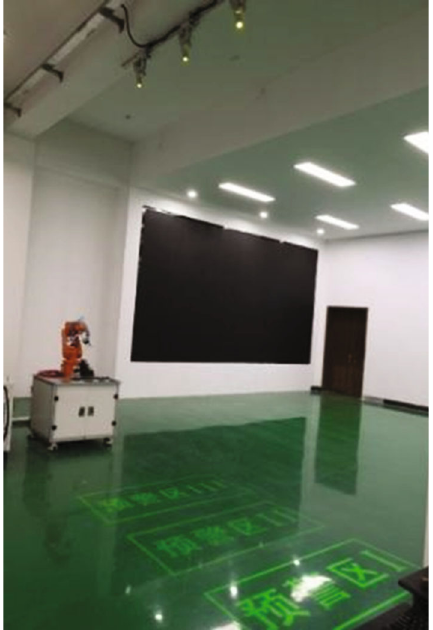
Figure 9: Mechanical safety protection system.